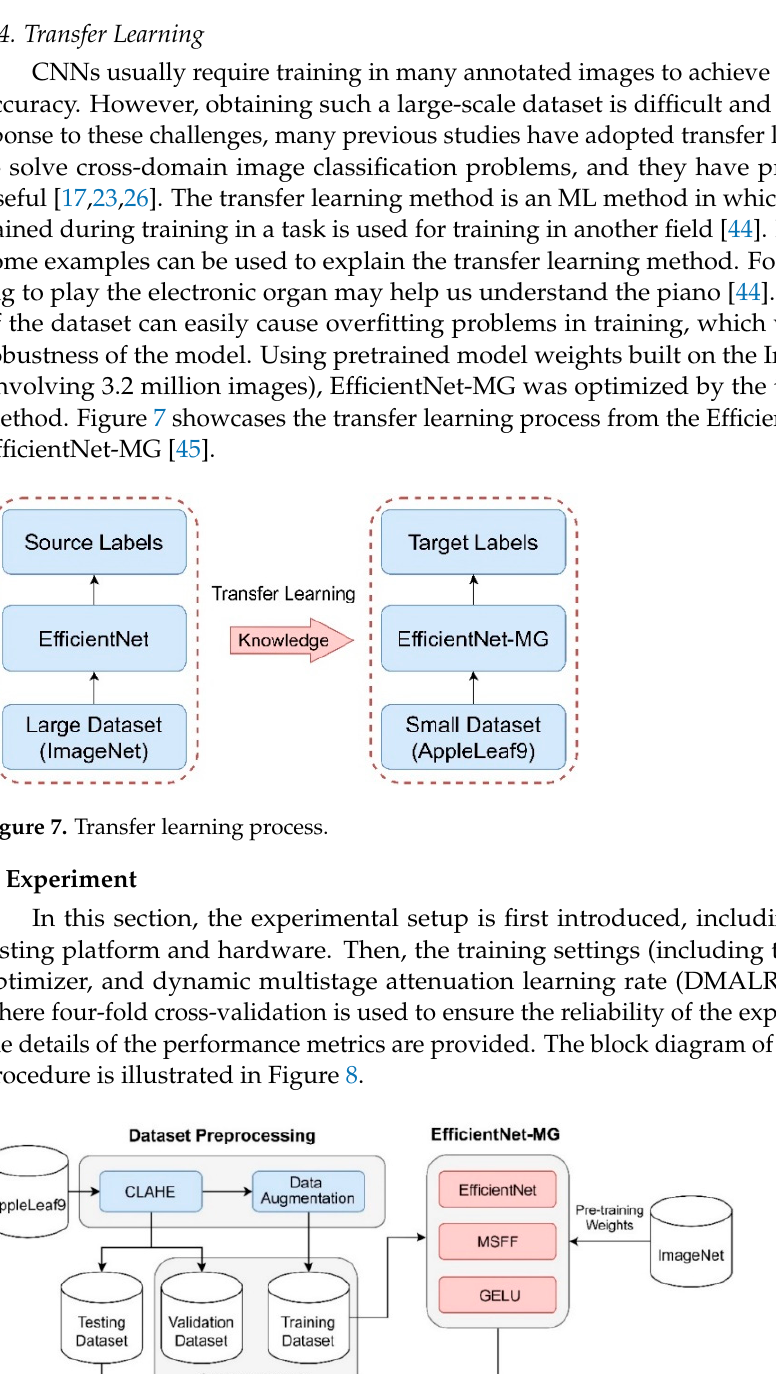
Figure 8. Block diagram of the experimental procedure.